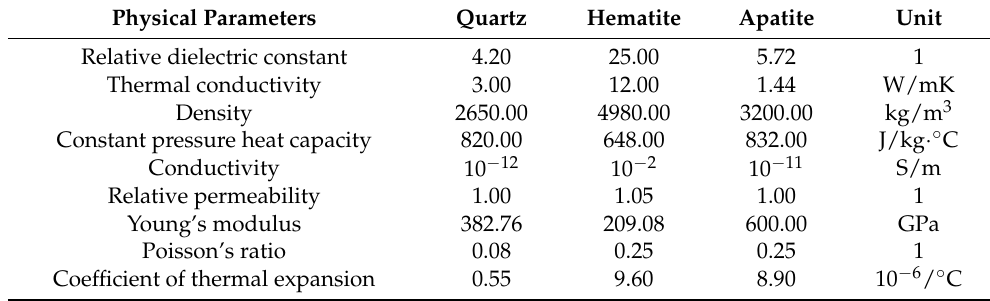
Table 2. Physical parameters of simulated materials.